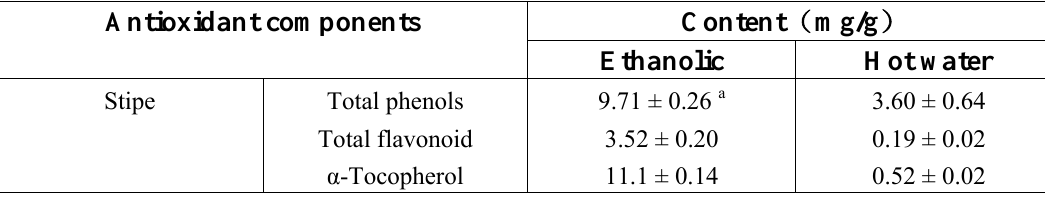
Table 3. Contents of total phenols, total flavonoid, tocopherols, ascorbic acid and polysaccharide of various extracts from Coprinus comatus